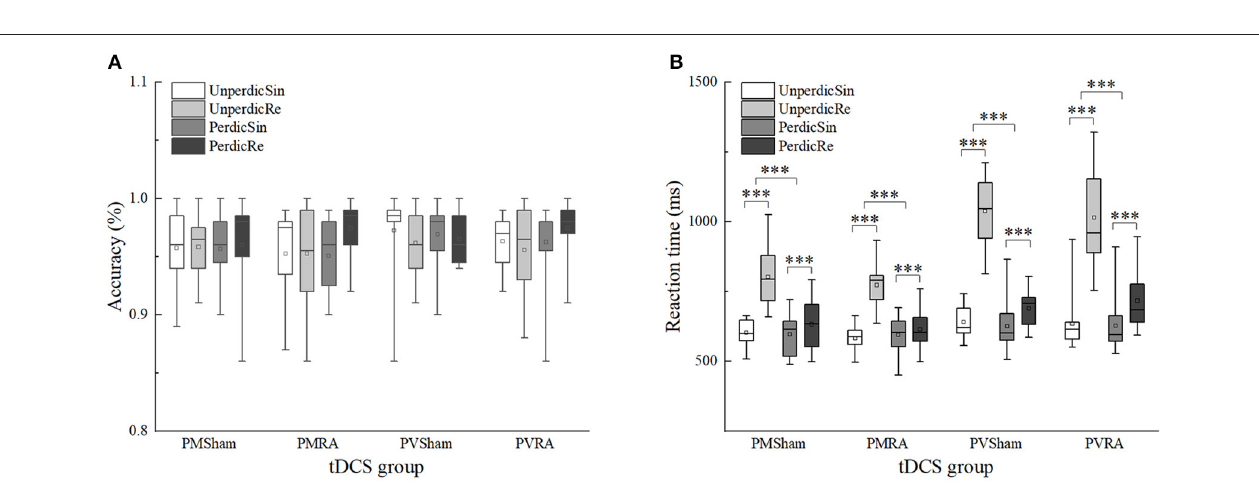
FIGURE 6 | Effects of tDCS in accuracy and reaction time between single and repeat trials in different task types and task predictability. (A) Effects of tDCS in accuracy between switch and repeat trials. (B) Effects of tDCS in reaction time between switch and repeat trials. UnperdicRe, repeat trials in unpredictable tasks; UnperdicSin, single trials in unpredictable tasks; PerdicRe, repeat trials in predictable tasks; PerdicSin, single trials in predictable tasks; PMSham, parity/magnitude task in sham tDCS group; PMRA, parity/magnitude task in RA tDCS group; PVSham, parity/vowel-consonant task in sham tDCS group; PVRA, parity/vowel-consonant task in RA tDCS group. *** p <